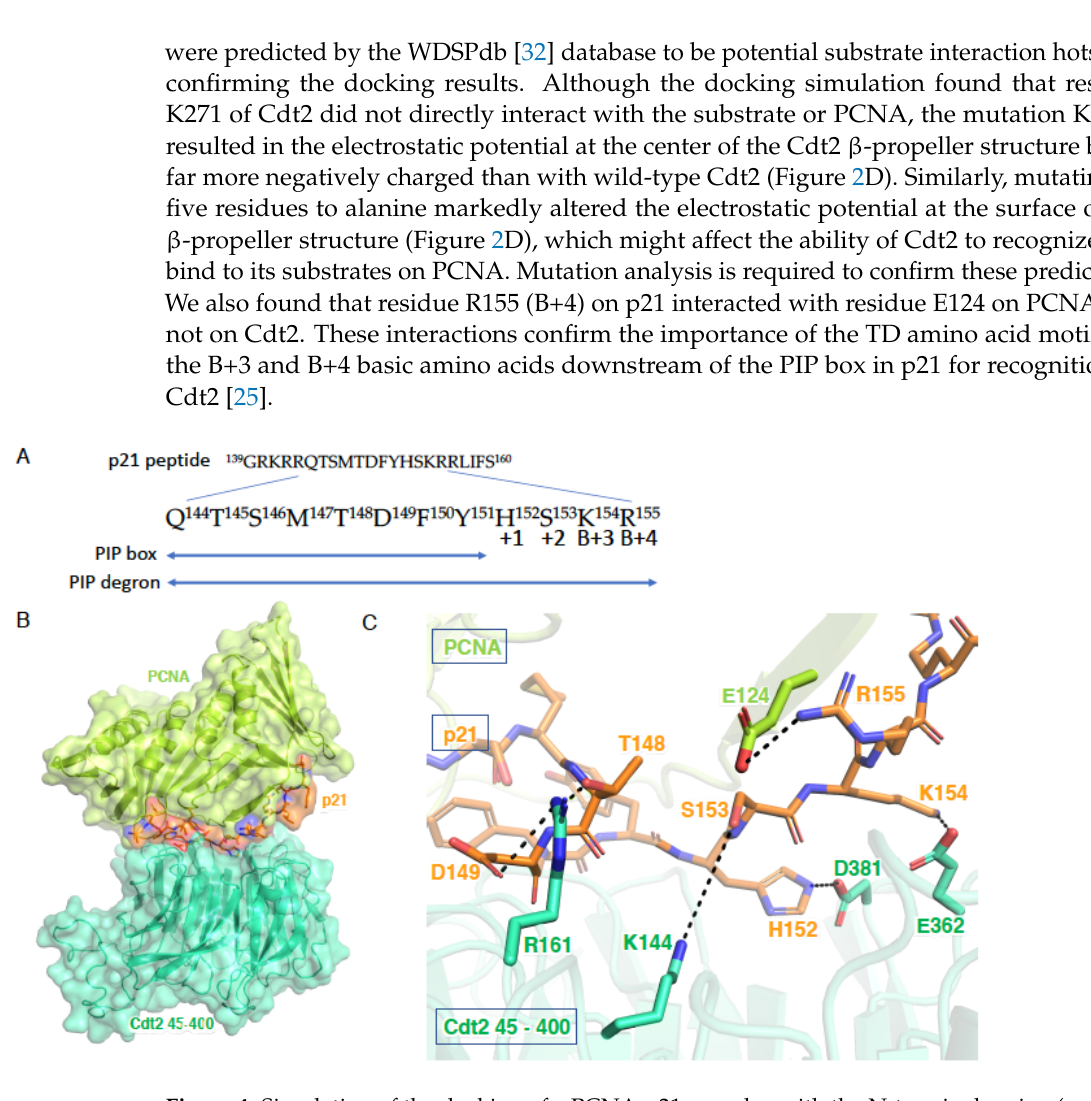
Figure 4. Simulation of the docking of a PCNA-p21 complex with the N-terminal region (residues 45–400) of Cdt2. ( A ) Amino acid sequences of the p21 PIP box and PIP degron. ( B ) Schematic showing the docking in solution of the PCNA-p21 complex (PDB ID: 1AXC) with the N-terminal structure Cdt2. ( C ) Schematic showing the possible hydrogen bonding of residues R161, K144, D381, and E362 of Cdt2 with the p21 peptide and residue R155 of p21 with E124 on PCNA.